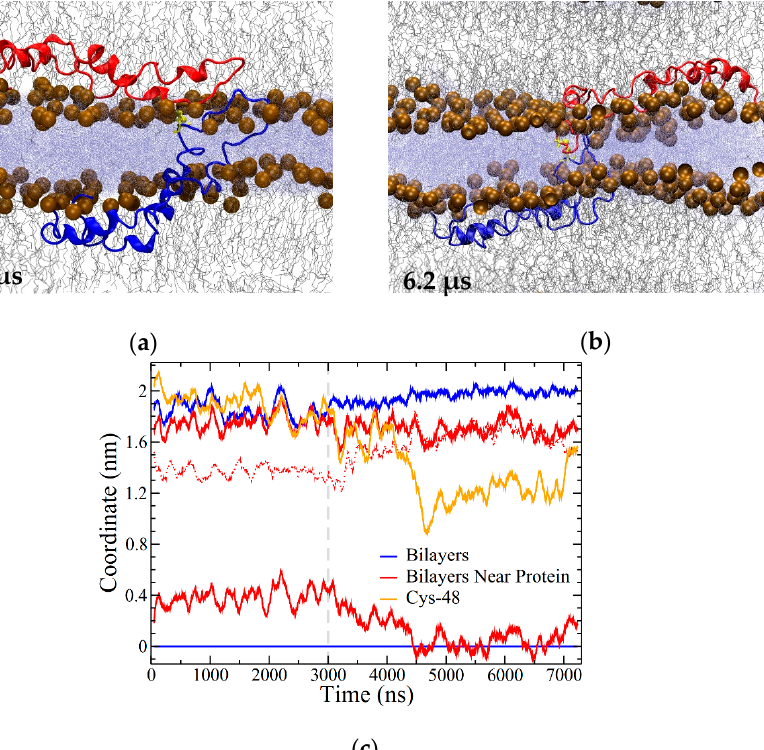
Figure 10. Open In Two Bilayers (OI2) system ( a ) snapshot at 2.5 µ s; ( b ) snapshot at 6.2 µ s (3.2 µ s into the high-temperature portion of the simulation). ( c ) Coordinate plot illustrating the distance between the bilayers around the protein and overall. Coordinates were measured using the highest-density positions of phosphorus atoms in the lipid headgroups, as described in the Methods section. The position of the lower leaflet was set as zero, with all other positions in reference to it. Blue lines illustrate the bilayer separation overall. Red lines show the bilayer positions within 1 nm of the portion of SP-B in the water layer. The dashed red line corresponds to the di ff erence between the red lines (i.e., the bilayer separation). The location of C48 is shown in orange. The dashed grey line corresponds to where temperature was increased from 310 to 340 K. The positions have a resolution of approximately 0.07 nm. Running averages are over 100 points, with 2 ns between